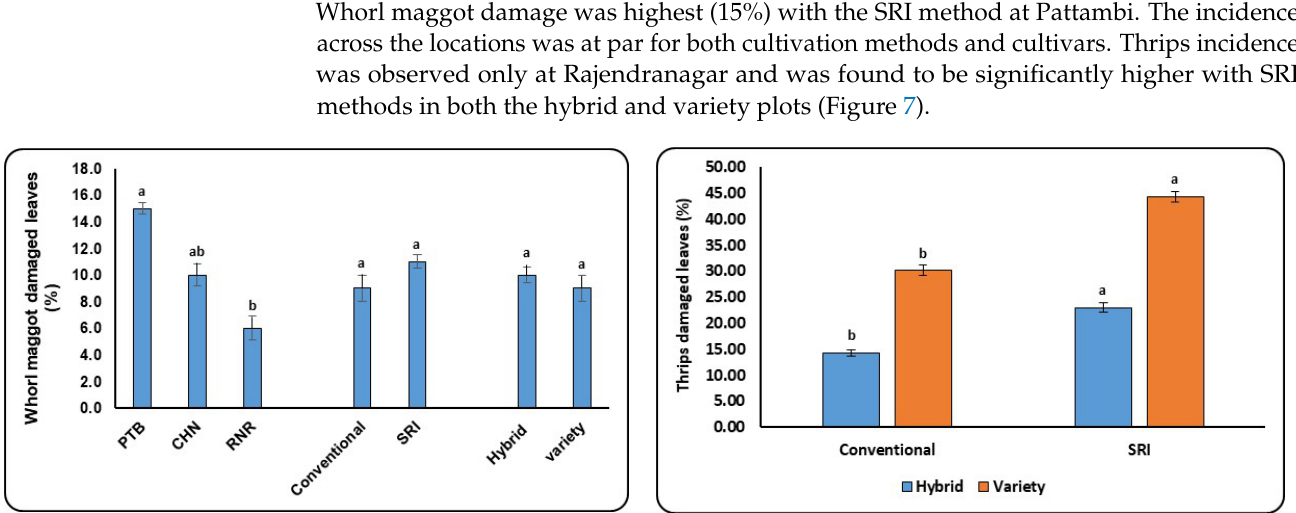
Table 2. Grain yield recorded in cultivation methods (kg ha − 1 ).